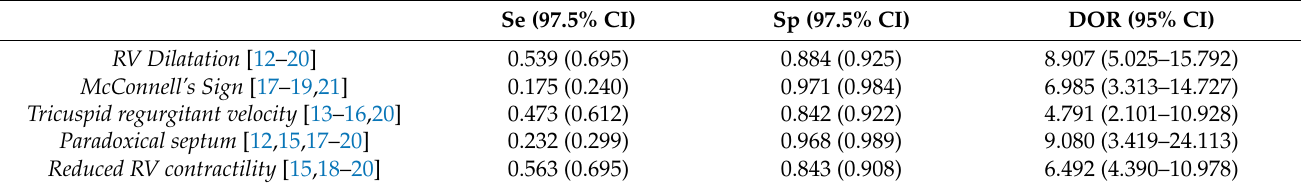
Figure 3. Fagan plot for right ventricle dilatation. Table 2. Sensitivity analysis and diagnostic odds ratio from meta-analysis.